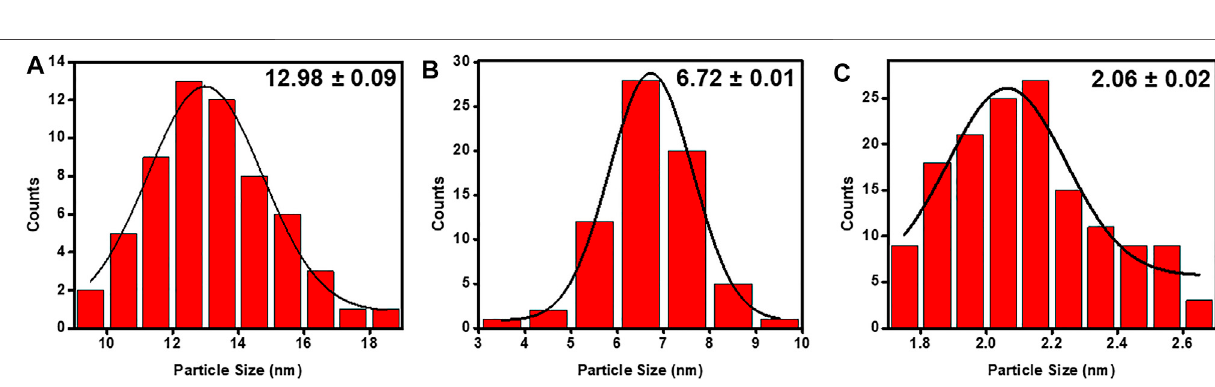
Frontiers in Chemistry |